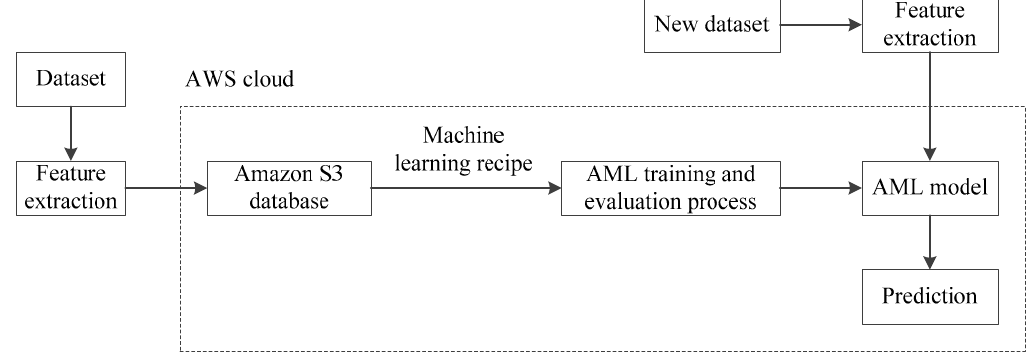
Figure 11. The machine learning model creation workflow.